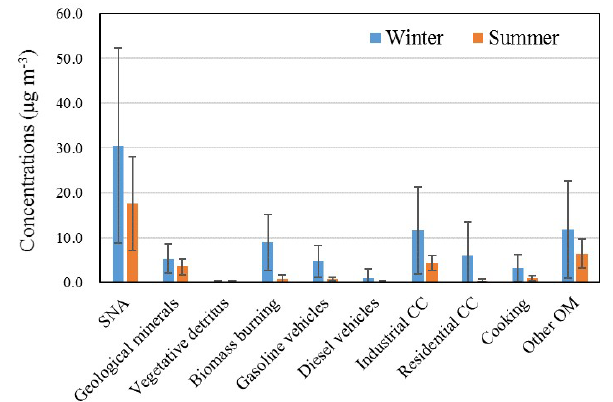
Figure 10. Seasonal average PM 2 . 5 source contribution estimates from the CMB